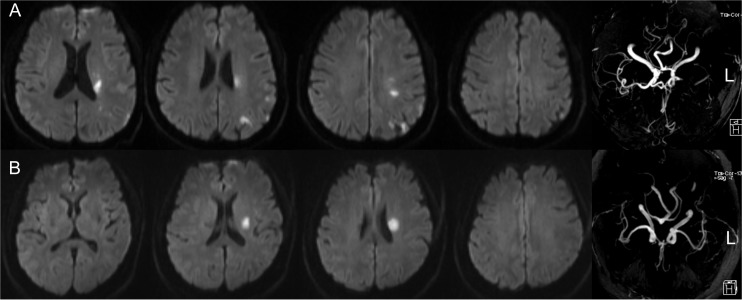
The topographical distribution of infarct lesions and etiologic subtype of minor stroke.A. minor stroke with occlusion of left middle cerebral artery (MCA) and multiple cerebral infarcts which located in cortex, internal watershed, and posterior cortical watershed, the etiologic subtype was considered as large artery atherosclerosis. B. minor stroke with single subcortical infarction in the left MCA perforator territory but without parent artery disease, the etiologic subtype was considered as small artery occlusion.